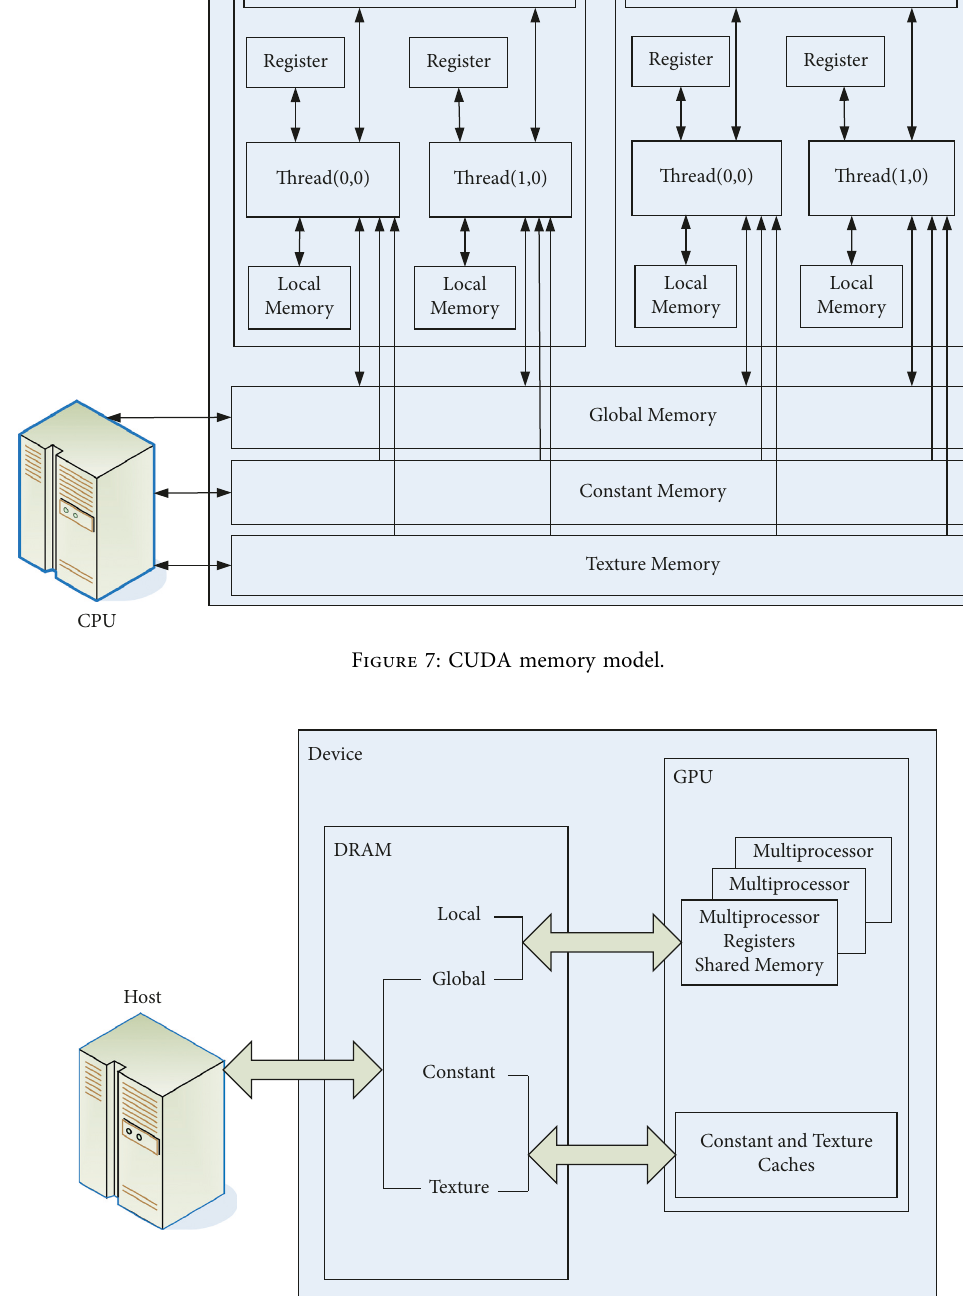
Figure 8: GPU device memory